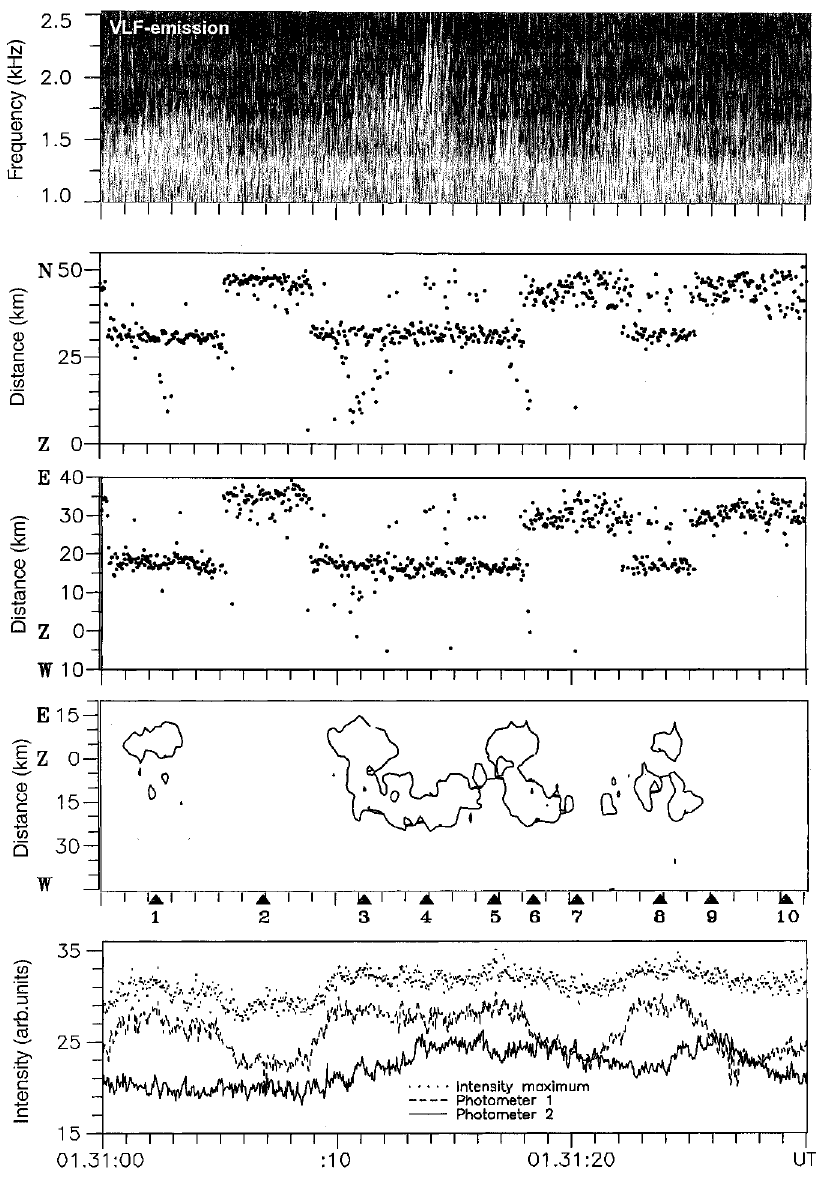
Fig. 1. The results of computer analysis of simultaneous ELF-VLF emission and auroral pulsation data. The uppermost panel shows the dynamic spectrum of the low-frequency emis- sions. The consequent locations of luminosity maxima for each TV frame in geomagnetic N-S and E-W directions are shown in the second panel and the third panels , correspond- ingly. The fourth panel shows the contour of keogram of pulsations (at level of 80% of maximum luminosity in the interval) along the band marked by the lines in the first square in Fig. 2. Z means zenith in panels 2 to 4 . Fifth panel presents the variations of intensity maxima ( dotted curve ) and auroral intensity in two windows shown in Fig. 2 by circles (photometers 1